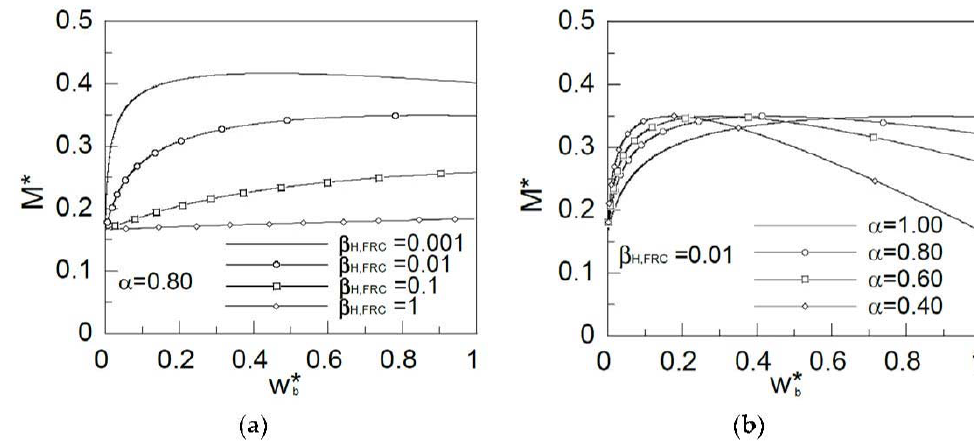
Figure 5. Influence of ( a ) the brittleness number, β H,FRC ; and ( b ) the ratio between f Ftu and f Fts , α .